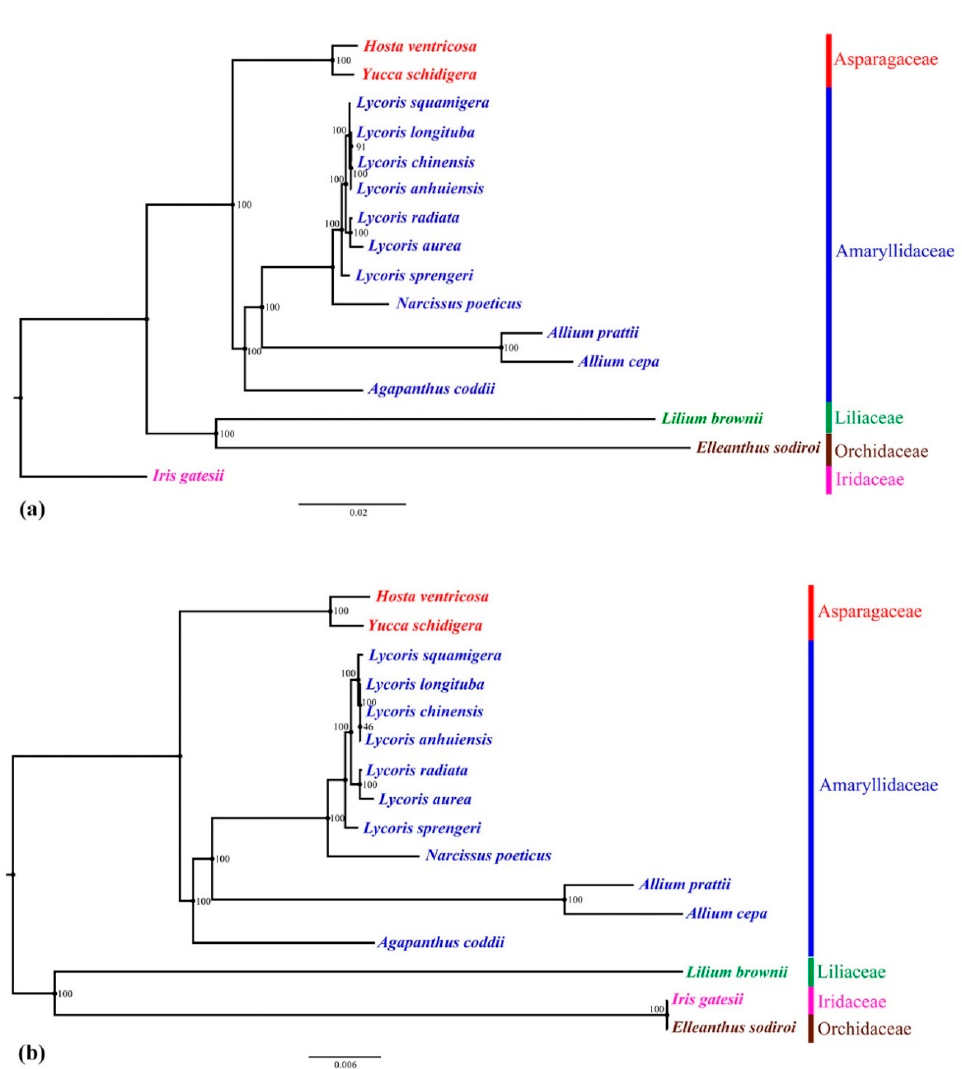
Figure 5. Phylogenetic relationships of the 16 species by maximum likelihood (ML) analyses. ( a ) The topology was constructed by the complete cp genome sequences. ( b ) the tree was constructed based on 72 protein-coding genes.